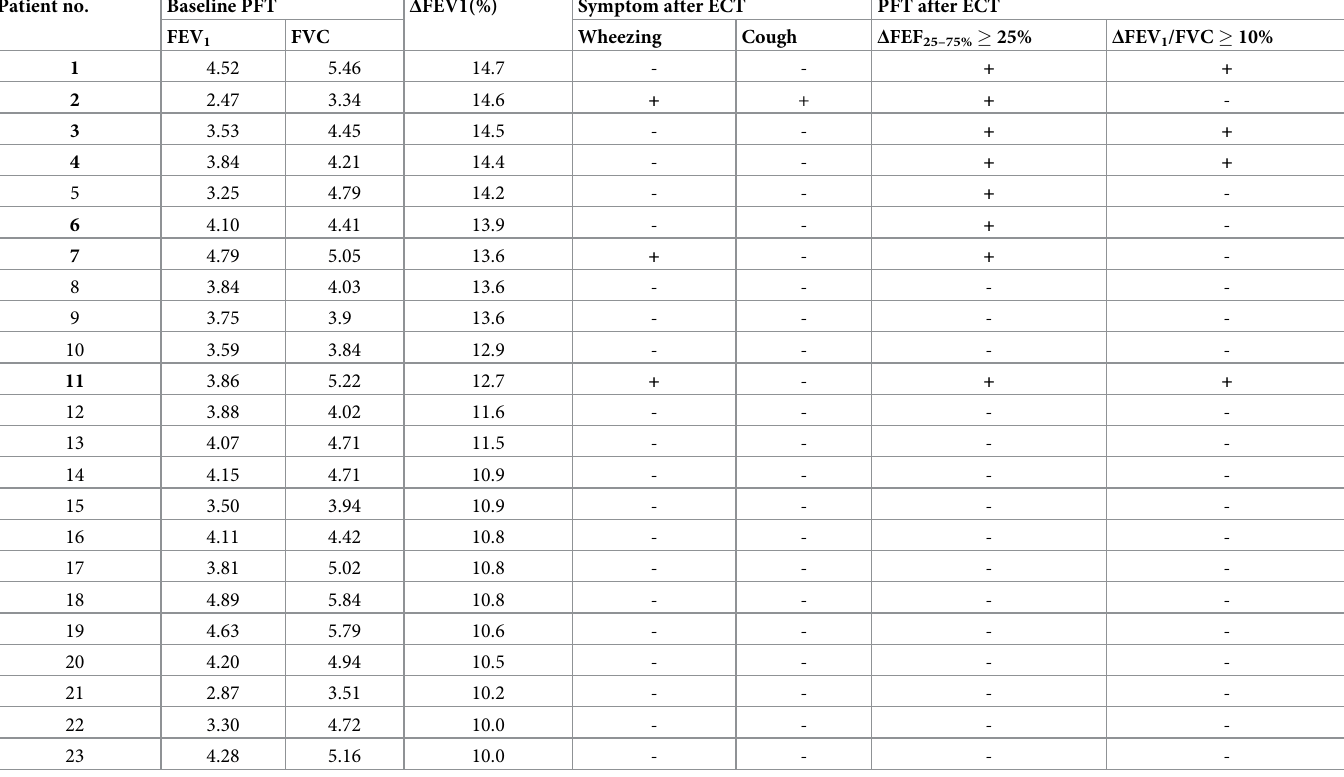
Table 3. Indicators of airway obstruction in the borderline group (n = 23). Patient no.